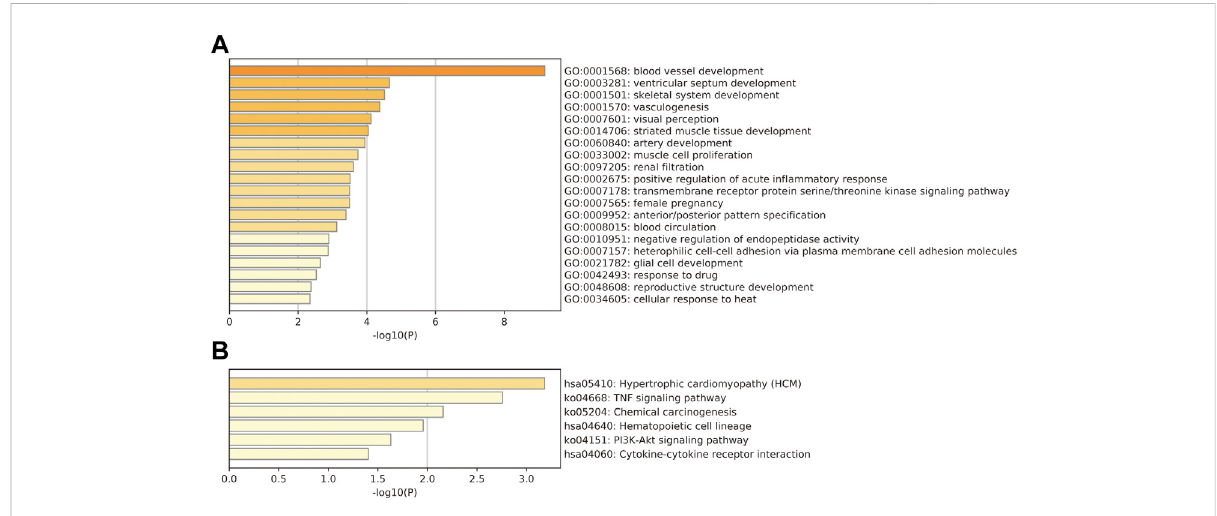
FIGURE 5 Functional annotation analysis for the validated cis-nearby-targeted DEmRNAs of DElncRNA gathering genes. (A) GO analysis. (B) KEGG pathway analysis. The vertical axis shows the annotated functions of the target genes. The horizontal axes show the enrichment score ( − log10 transformed p value) and the gene number of each cluster, respectively. Only the top 10 signi fi cantly enriched clusters are